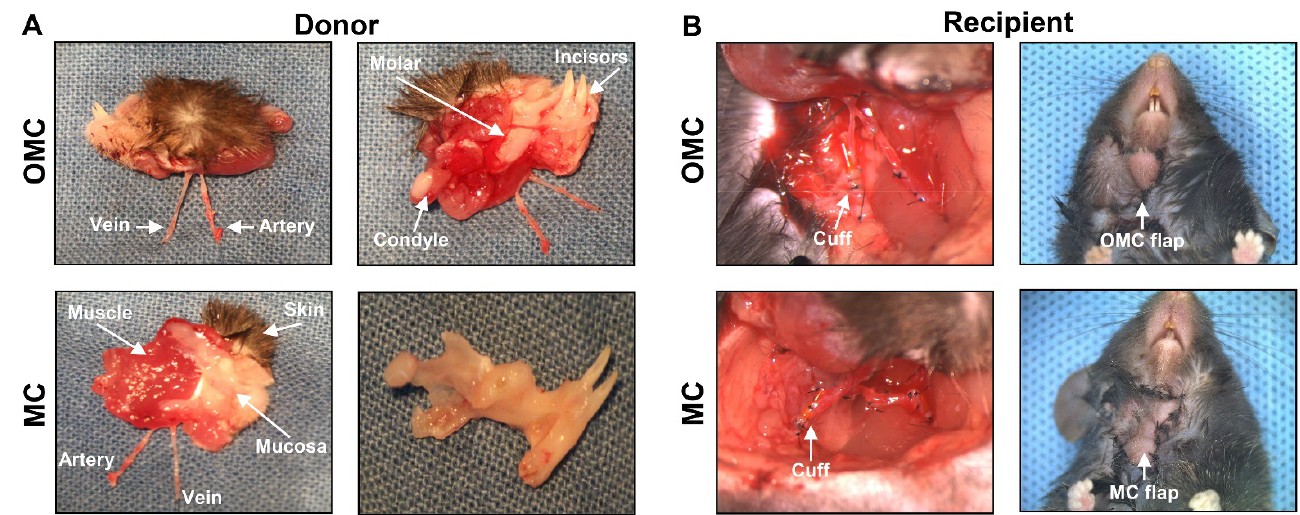
Figure 1. Surgery in the facial osteomyocutaneous (OMC) and myocutaneous (MC) groups. ( A ) Donor flap of the facial OMC group, including the mandible in addition to the skin, muscle, oral mucosa, and vessels. Donor flap of the facial MC group, containing only the skin, muscle, oral mucosa, and vessels, with the mandible removed. ( B ) The recipient’s vessels were anastomosed using the cuff technique for syngeneic facial OMC and MC transplantation.